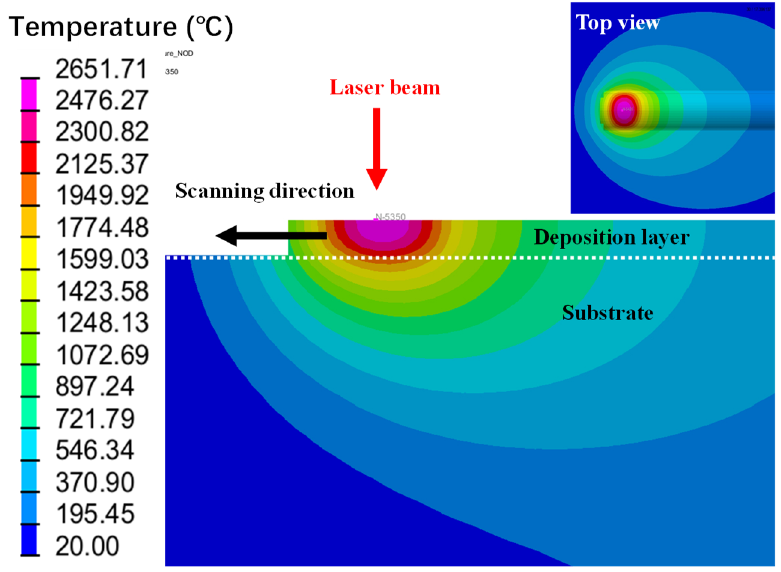
Figure 6. Transverse section and top view of temperature distributions for single-track LMD.